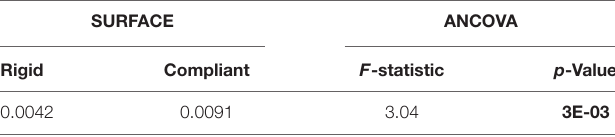
TABLE 1B | Linear regression results on slope (N − 1 msec − 1 ) in total (pooled) for each surface and ANCOVA results across both surfaces.